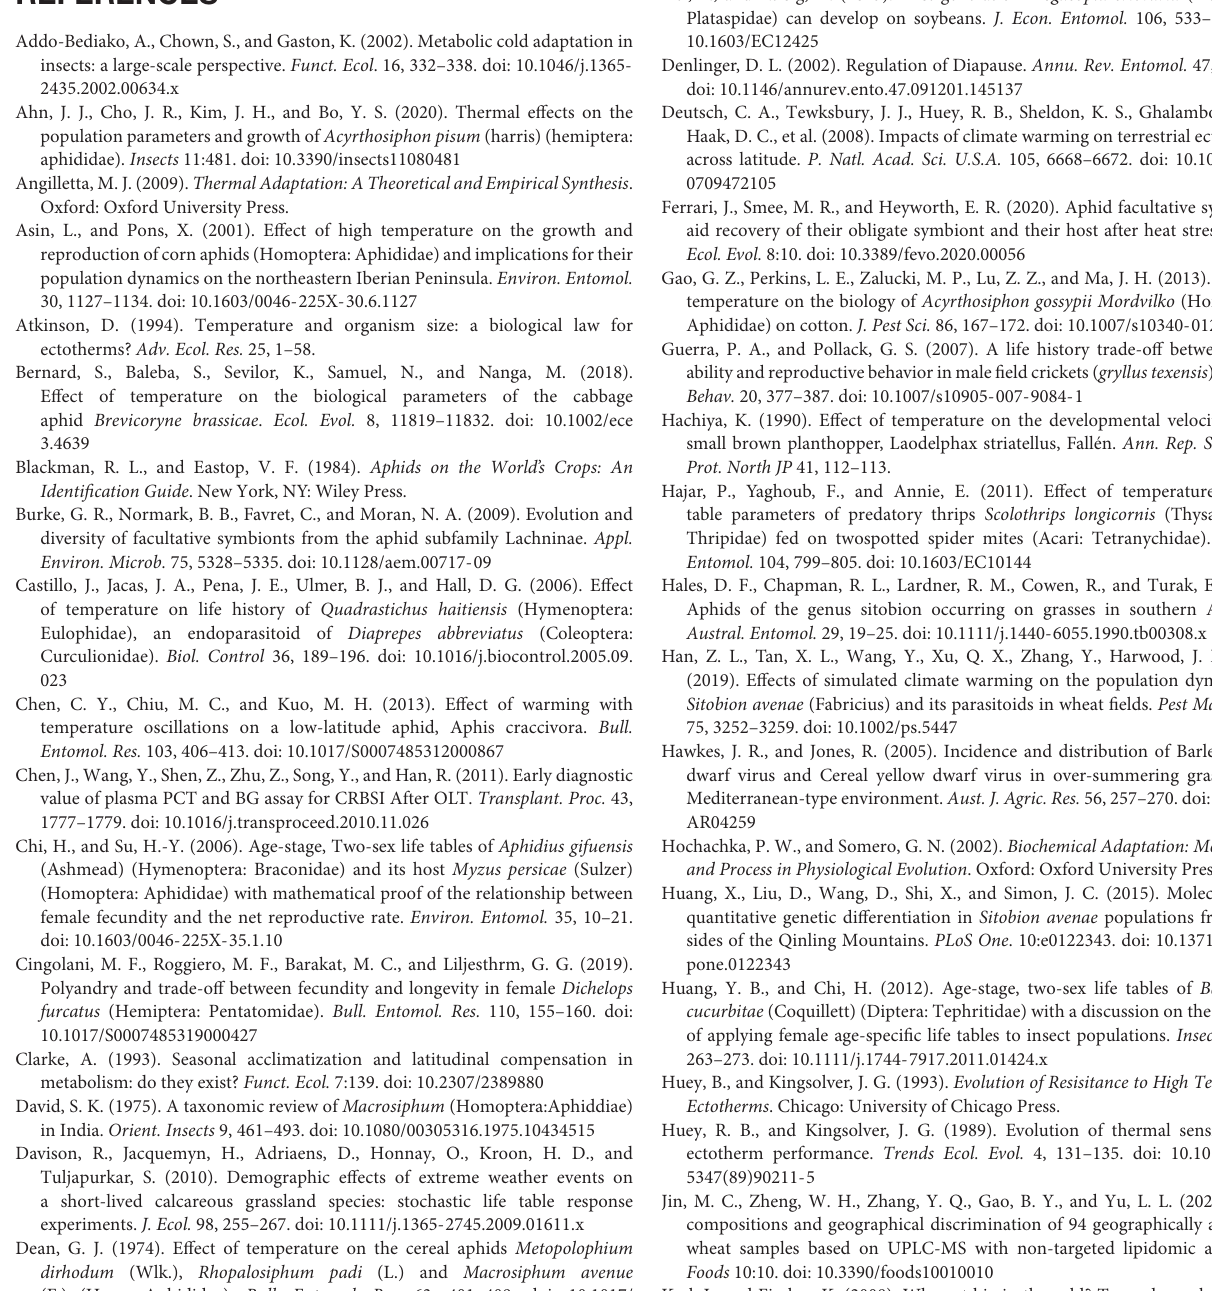
wheat samples based on UPLC-MS with non-targeted lipidomic approach. Foods 10:10. doi: 10.3390/foods10010010 Karl, I., and Fischer, K. (2008). Why get big in the cold? Towards a solution to a life-history puzzle. Oecologia 155, 215–225. doi: 10.1007/s00442-007-0902-0